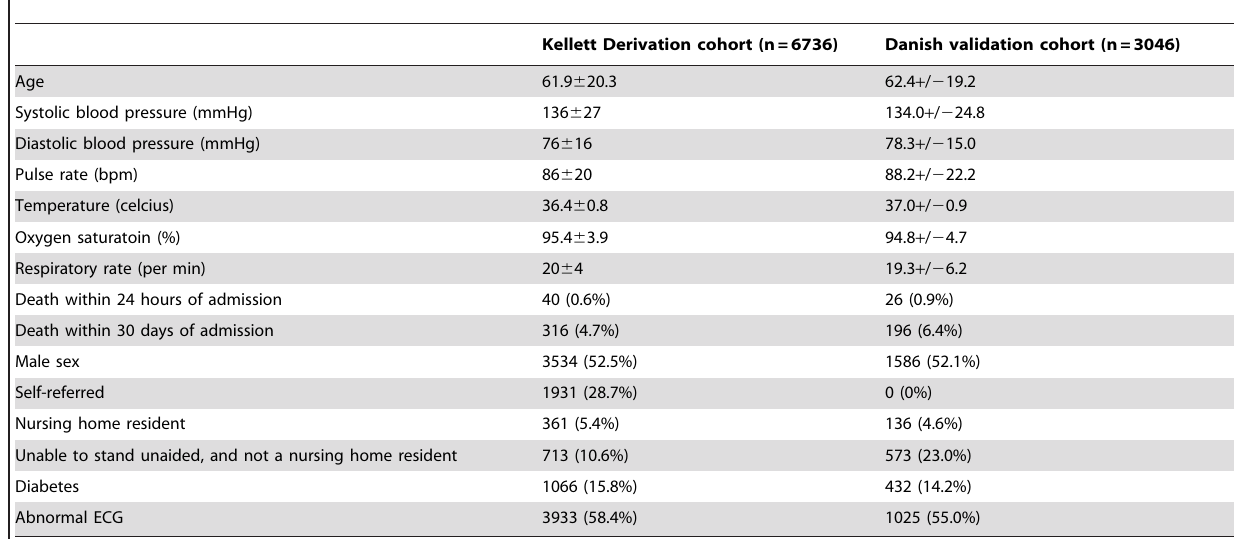
Table 3. Comparison between original derivation cohort and the danish validation